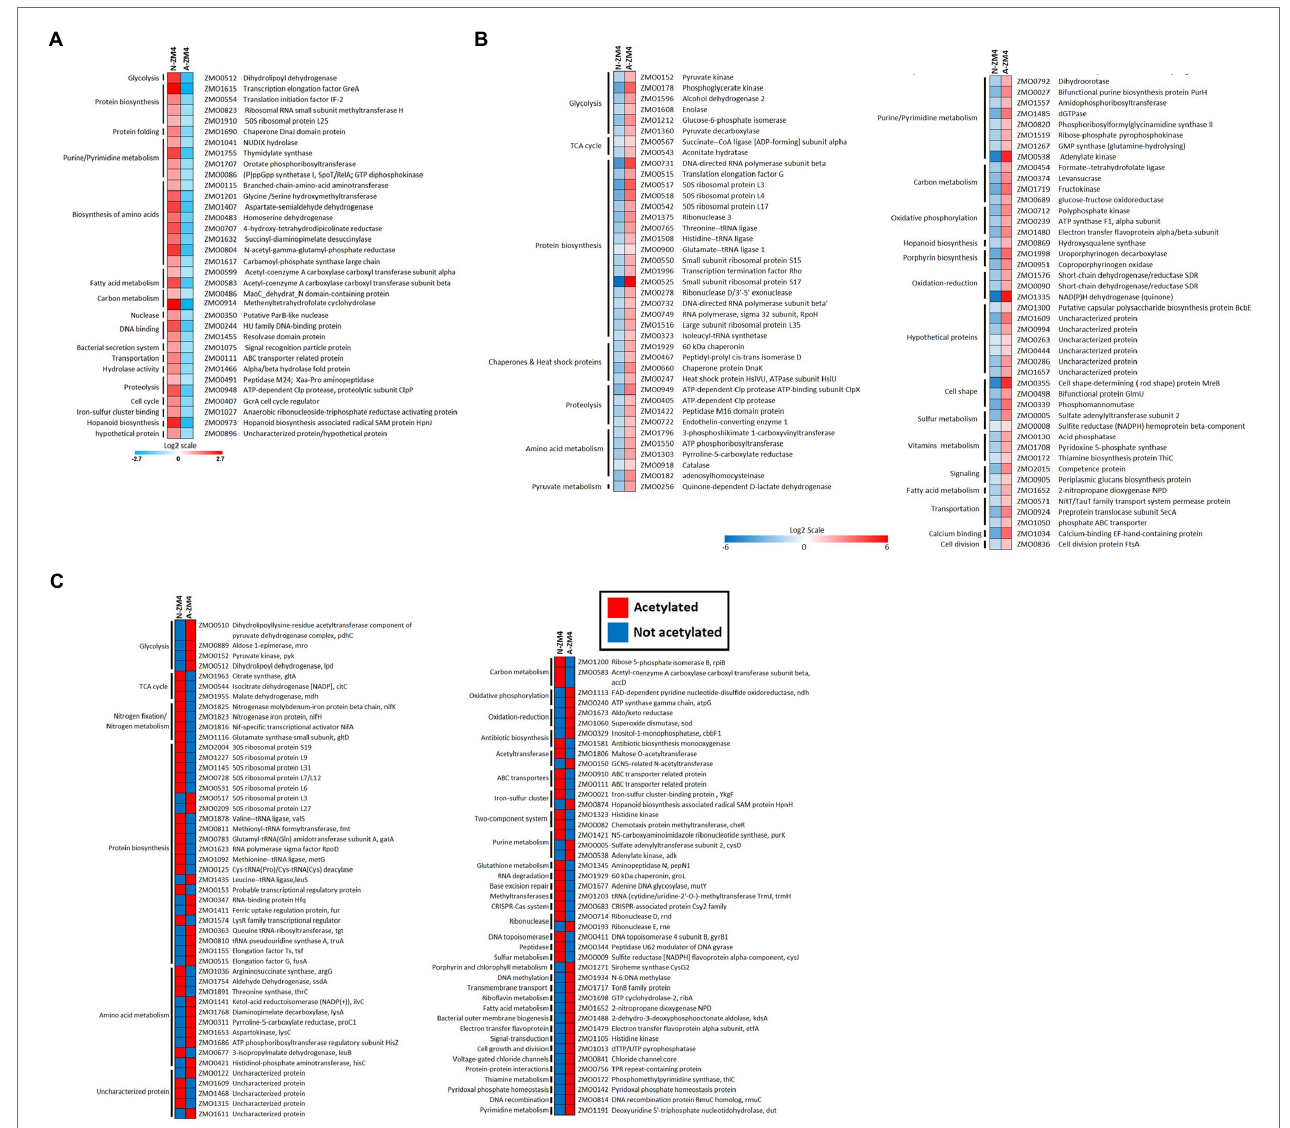
FIGURE 4 | Differential protein acetylation in Z. mobilis under N 2 -fixing and non-fixing conditions. (A) Heatmap showing the comparative acetylation quantitation for 34 uniquely acetylated proteins under N 2 -fixing condition. (B) Heatmap showing the comparative acetylation quantitation for 83 uniquely acetylated proteins under non-fixing condition. For (A,B) , comparison were made between A-ZM4 and N-ZM4 and changes in proteins acetylation (fold-change, FC) are shown on the log2 fold scale, and quantitative data represent the average of three biological replicates. All quantitations were significant ( p < 0.05). (C) Heatmap showing non-FC-based protein acetylation across the growth conditions. For proteins that did not show relative changes in protein acetylation, the FC-based comparisons were not made; instead, changes in protein acetylation status are shown as follows: Red color indicates that protein is acetylated, Blue color indicates that protein is not